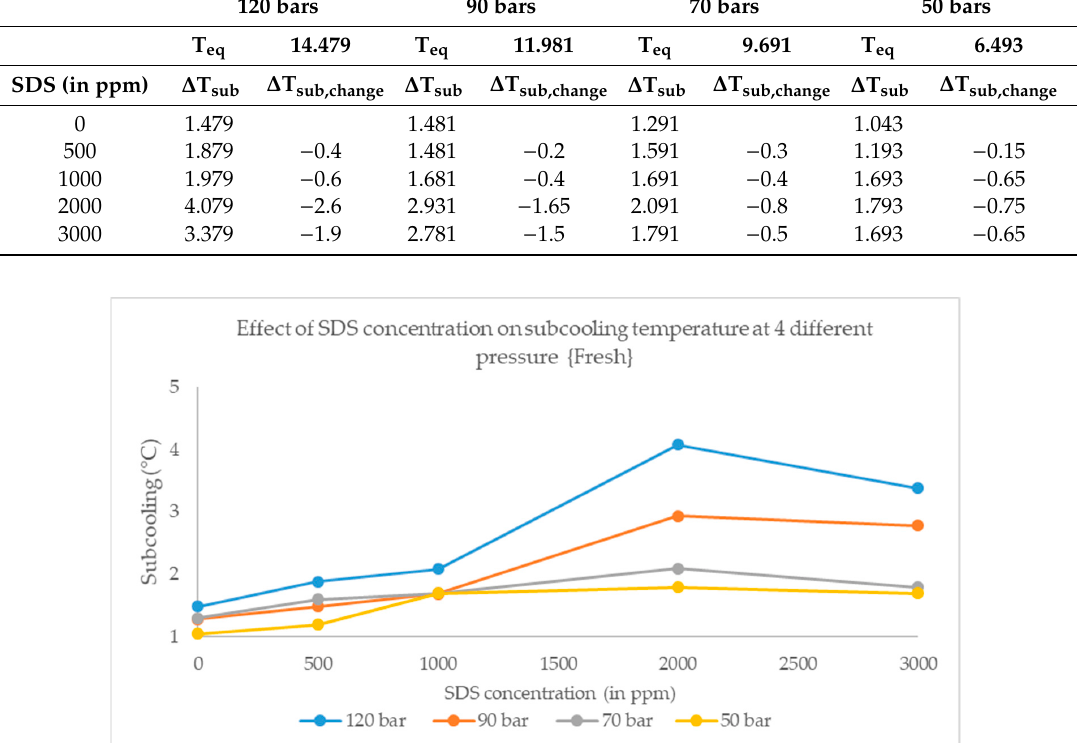
Figure 9. Sub cooling temperature vs. SDS concentration at different pressures. This figure shows the presence of critical micelle concentration (CMC) in the range of 2000–3000 ppm